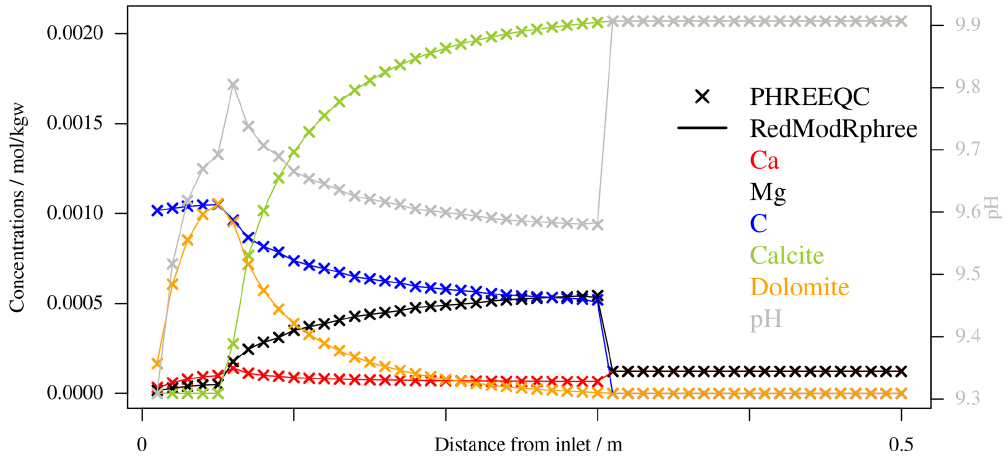
Figure 4. Profiles of variables across a 1D domain resulting from kinetic reactive transport simulations computed with the ReactTranspBalanceKin function and PHREEQC ’s ADVECTION keyword respectively, for validation. A MgCl from the left inlet of the domain which is initially at equilibrium with calcite, triggering the transient precipitation of Dolomite. Displayed are the relevant total dissolved concentrations and amounts of minerals (scale on the left y -axis) and pH (in gray, right y -axis) after 30 coupling iterations. The code used to produce this picture is included in the package as demo-validate